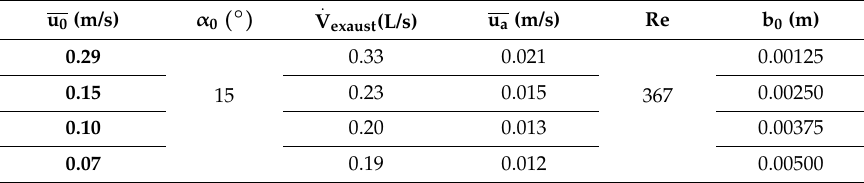
Table 3. Records of experimental results with variations in jet thickness.